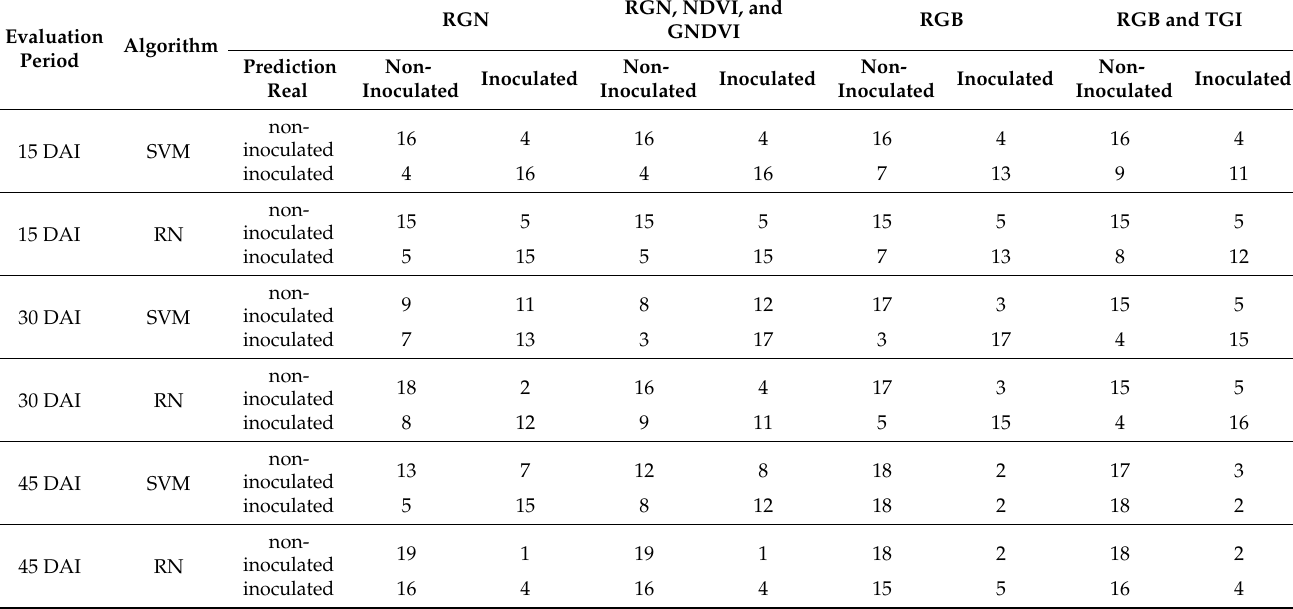
Table 3. Classification at 15, 30, and 45 days after inoculation (DAI).